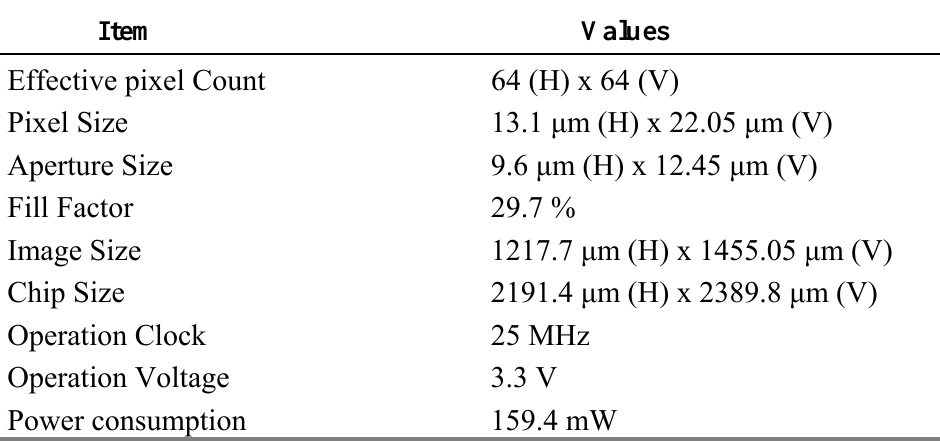
Table 1. Specification of the proposed CMOS image